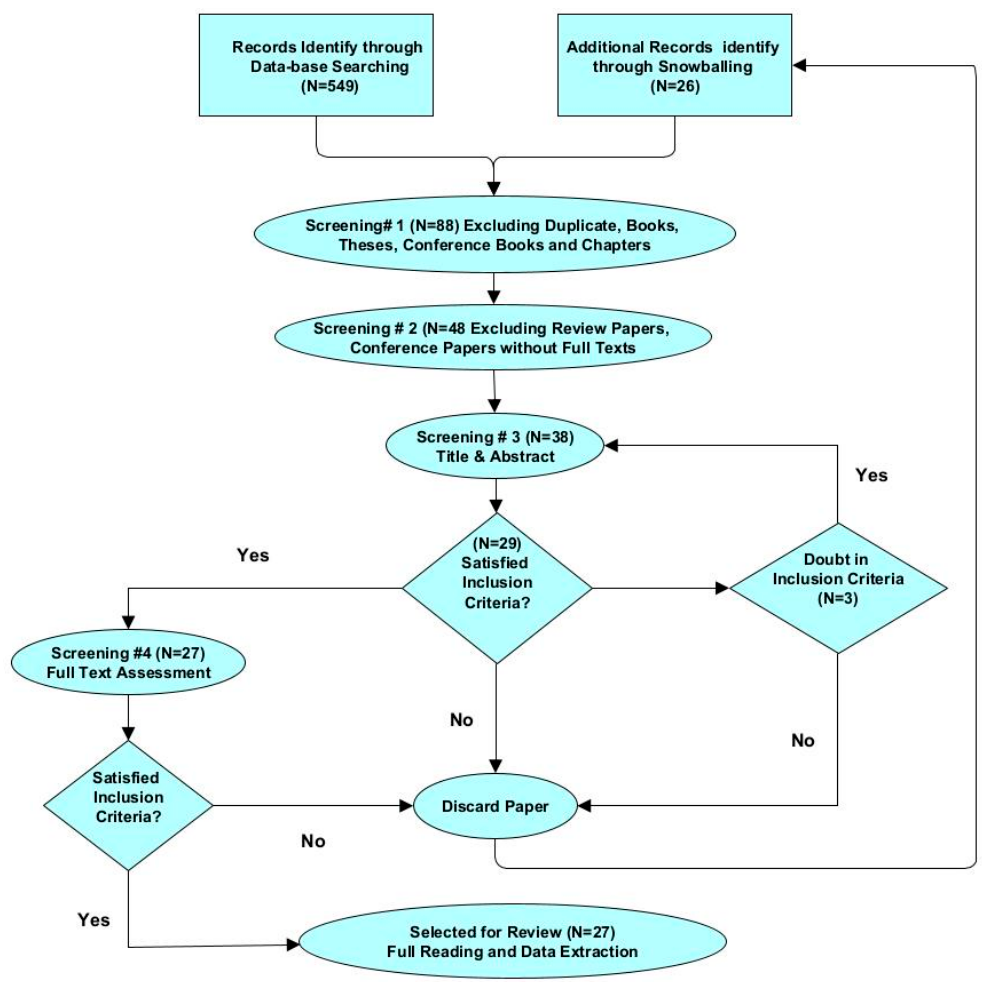
Figure 1. Method flowchart followed in the Systematic Literature Review (SLR) Process.